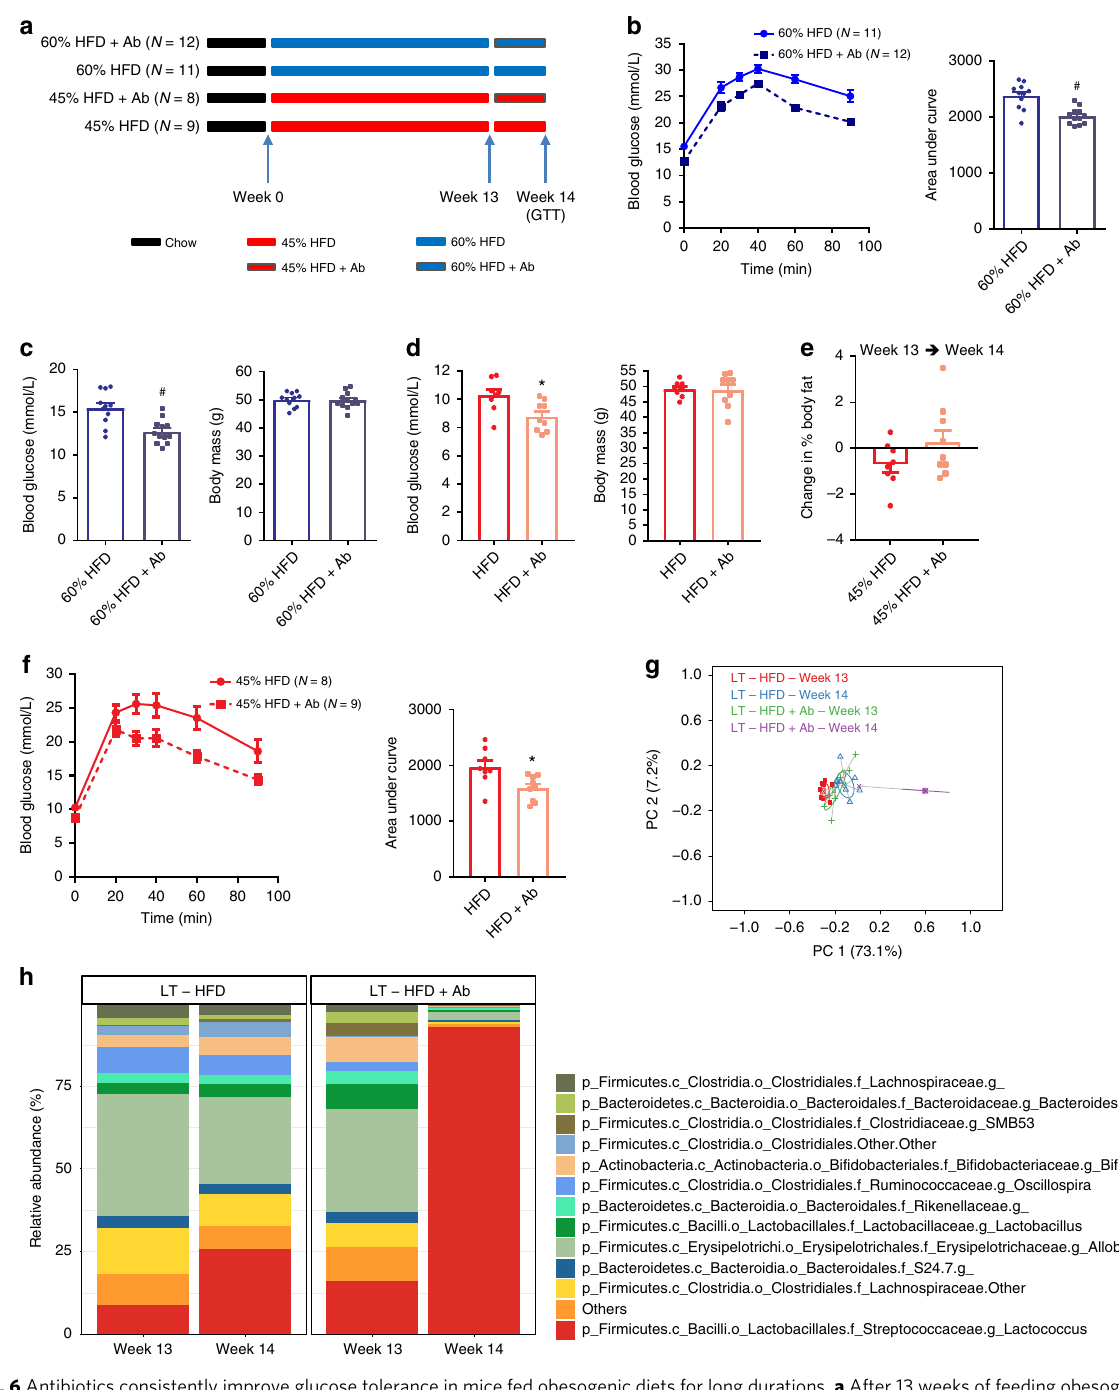
Fig. 6 Antibiotics consistently improve glucose tolerance in mice fed obesogenic diets for long durations. a After 13 weeks of feeding obesogenic HFD diets, mice were treated with or without antibiotics (1 mg/mL ampicillin and 0.5 mg/mL neomycin) in the drinking water for 1 week (60% HFD = 11; 60% HFD + Ab = 12; 45% HFD = 8; 45% HFD + Ab = 9). b Glucose tolerance test (GTT) (2 g per kg glucose i.p .) and area under the curve (AUC) in mice fed a 60% HFD with and without antibiotics. c , d Fasting blood glucose and body mass in mice fed 60% HFD ( c ) and 45% HFD ( d ) with and without antibiotics. e Changes in body fat % in mice fed 45% HFD with and without antibiotics. f GTT (2 g per kg glucose i.p .) and AUC in mice fed a 45% HFD with and without antibiotics. g PCoA of Bray-Curtis dissimilarity for all mice fed a 45% HFD with and without antibiotics. h Stacked bar graph showing the relative abundance of the 12 most abundant bacterial taxa (Genus level) for all mice fed a 45% HFD with and without antibiotics. Statistical signi fi cance was measured as p < 0.05 using Student t -test. Post hoc analysis was performed using Tukey ’ s multiple comparisons test (* p < 0.05; ** p < 0.01; # p < 0.001; ## p < .0001). Values are mean ±